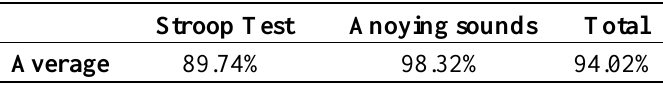
Table 21. Average by Test and